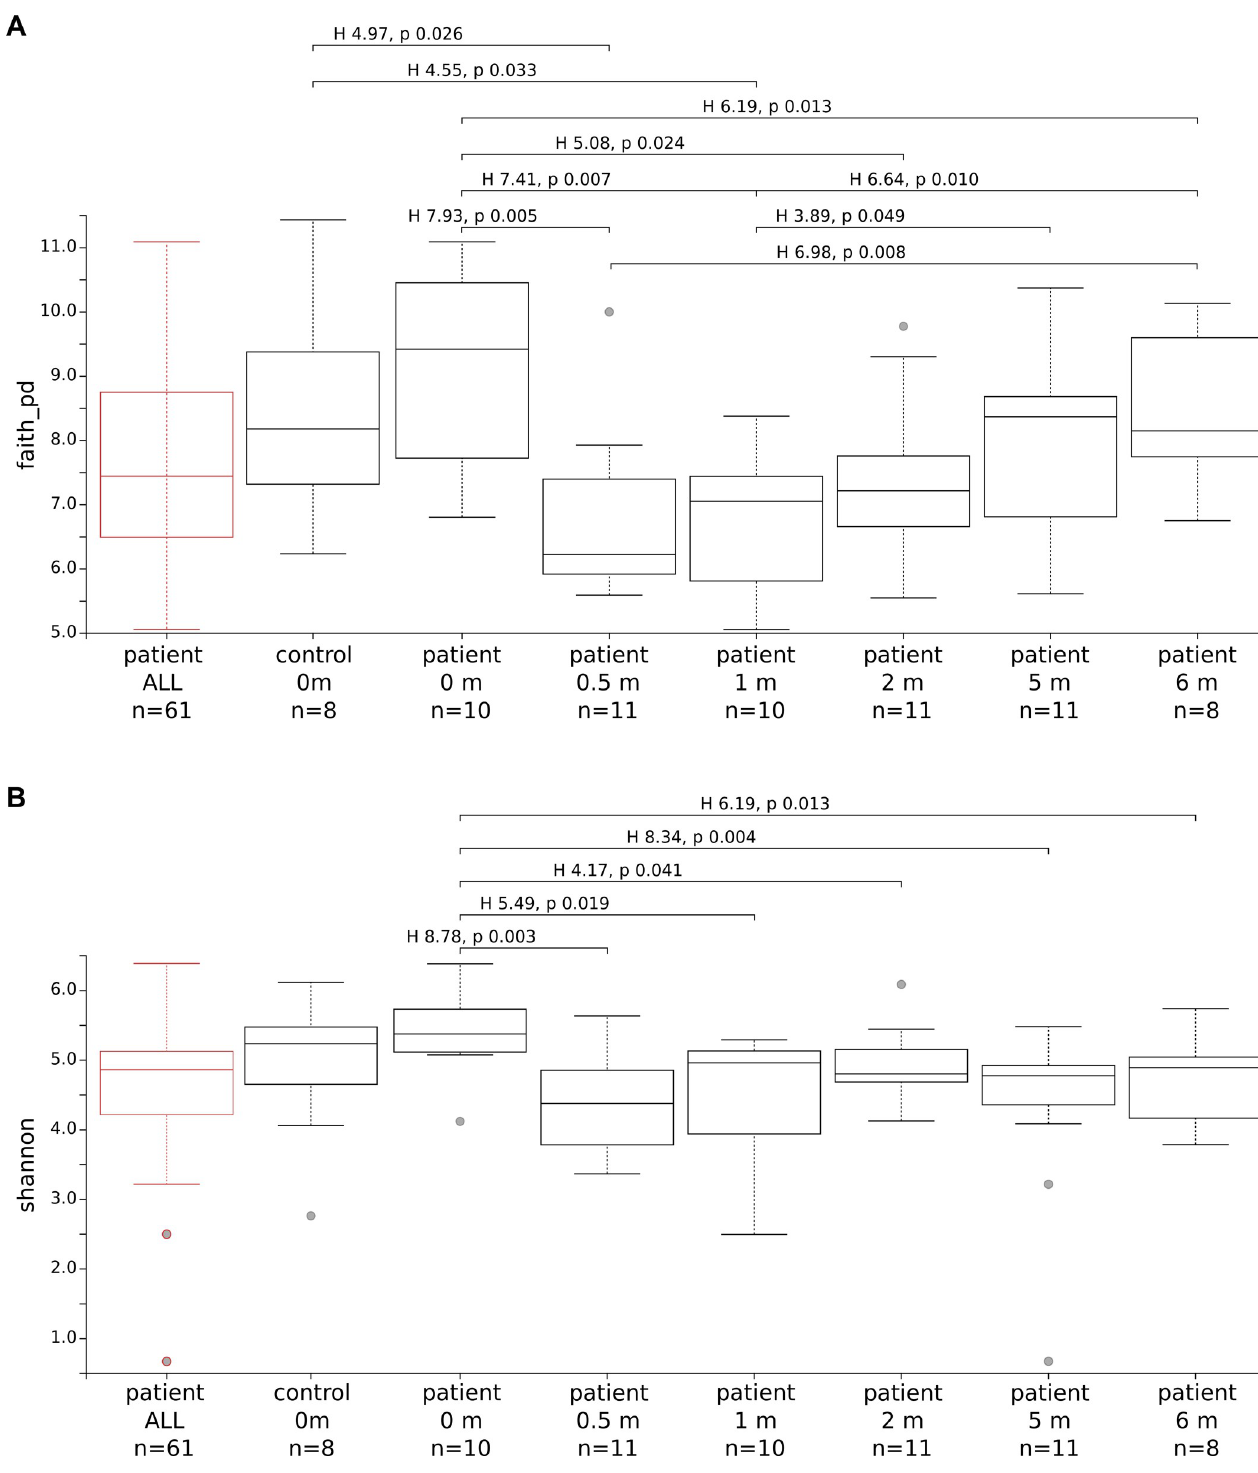
Fig 5. Alpha diversity for the sputum samples received from Bangladesh. A. Faith Phylogenetic Diversity. B. Shannon index. Samples from controls and TB patients are listed on the X-axis. TB patients are grouped according to the time-point. Grey dots represent outliers. Pairwise Kruskal-Wallis statistics are shown for p-values smaller than 0.05. The “patient ALL” group (red) was tested separately against the controls (test not statistically significant). Kruskal-Wallis test for all groups was 19.05 (p-value 0.004) for Faith Phylogenetic Diversity and 14.94 (p-value 0.021) for Shannon index.